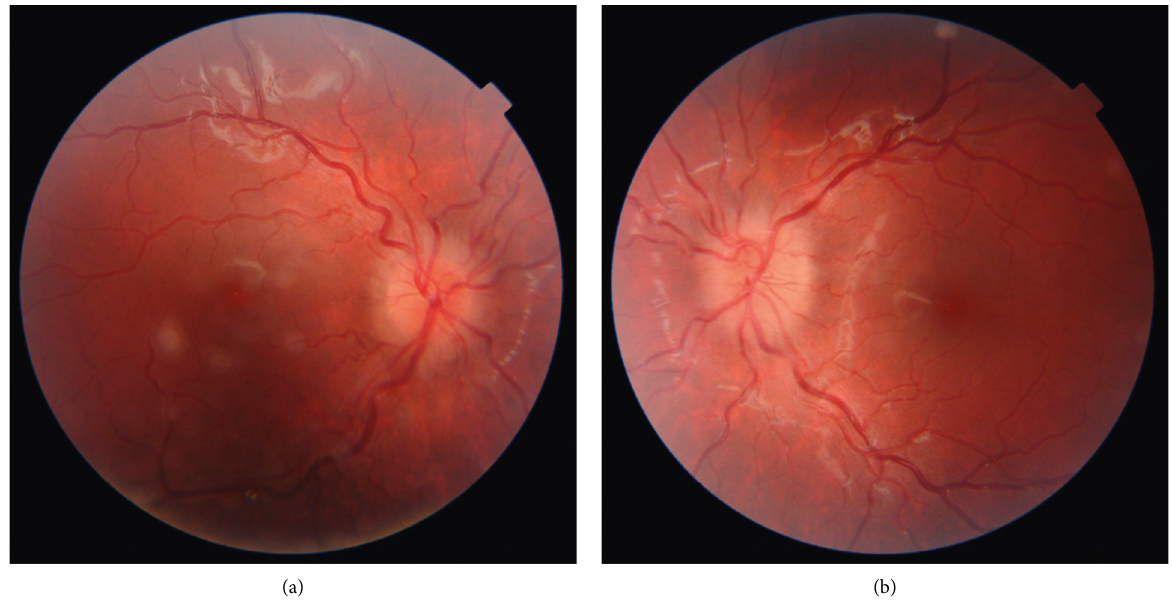
Figure 1: The fundus of the right (a) and of the left (b) eye at the baseline visit—optic disc edema and vessels tortuosity.